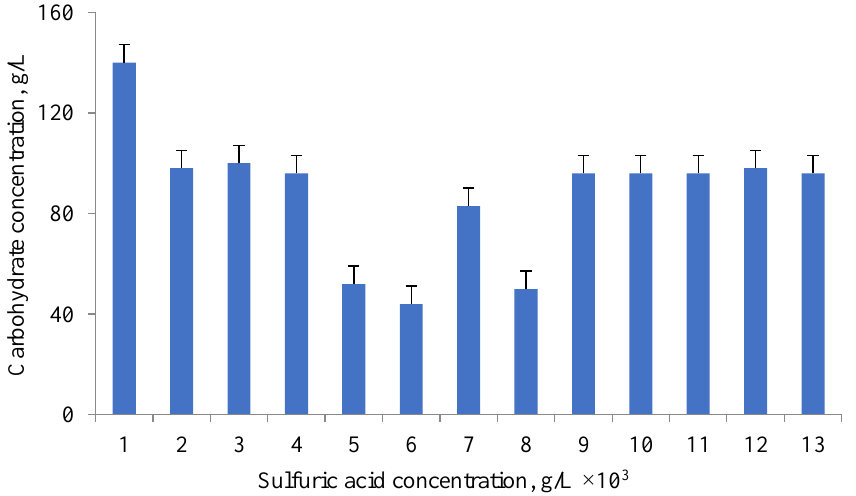
Figure 2. Carbohydrate (g/L) at various sulfuric acid concentrations during acid hydrolysis of 50 g/L of biomass.